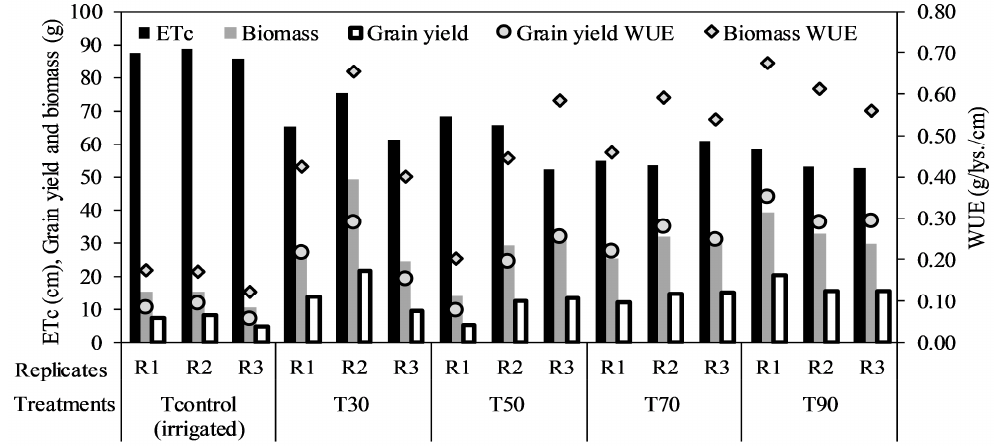
Figure 4. Measured crop evapotranspiration, grain yield and biomass, and obtained grain yield and biomass water use efficiency for different water table depths (30, 50, 70, and 90 cm) with three replications (R1, R2, and R3).